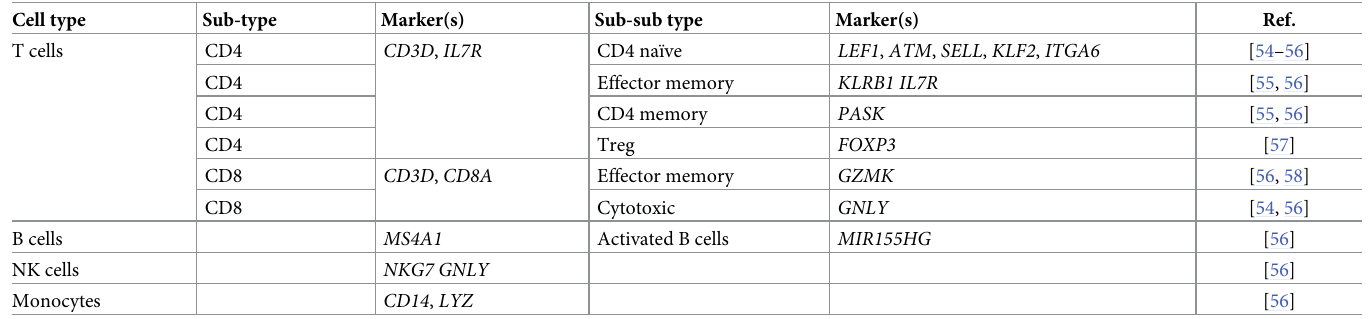
Table 4. mRNA markers used to define PBMC sub-populations in